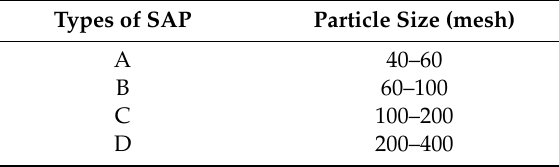
Table 7. Particle size of the SAP.